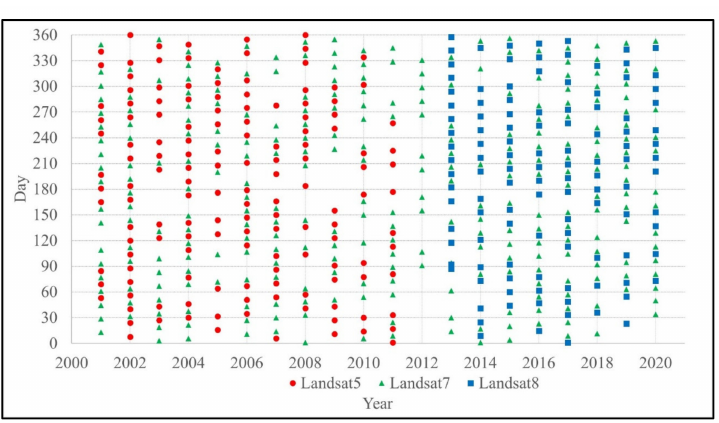
Figure 2. The distribution of available Landsat 5, 7, and 8 imageries from January 2001